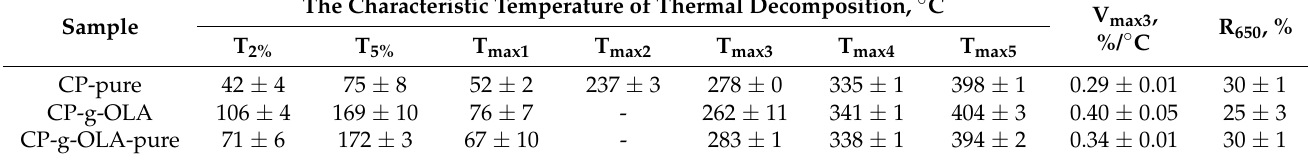
Table 6. TGA results of the fillers.